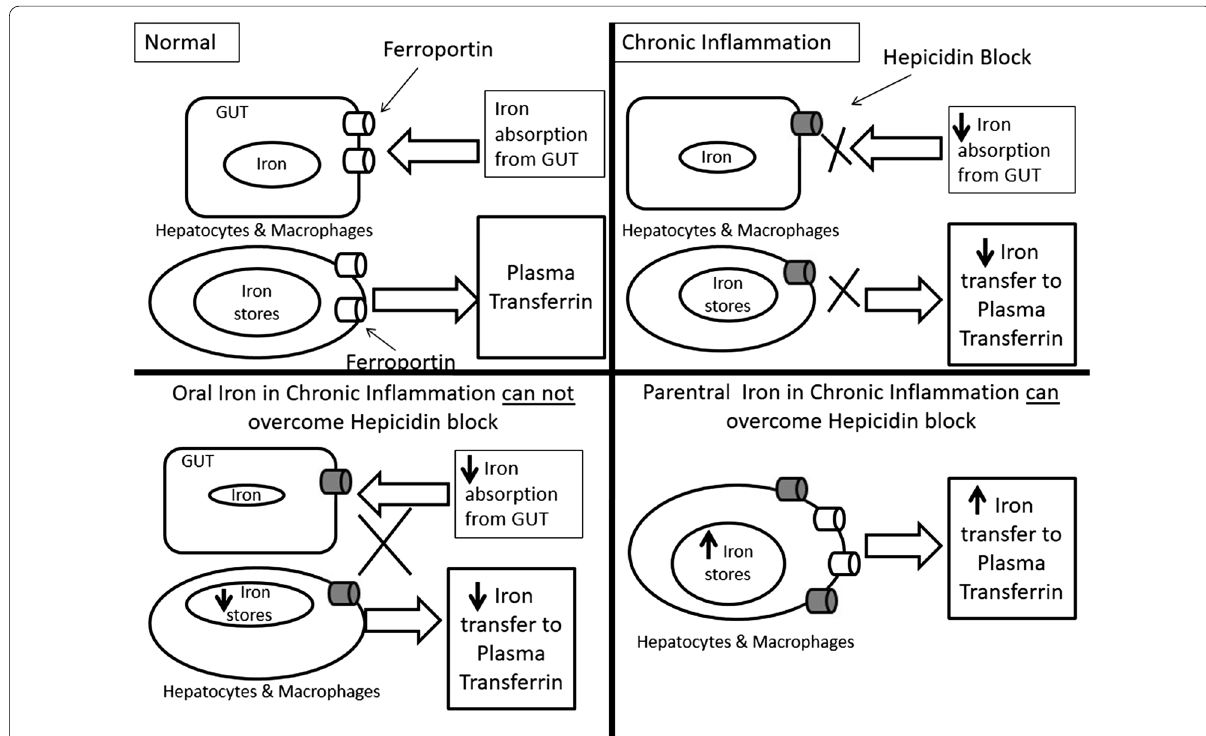
Fig. 2 Role of parenteral iron in heart